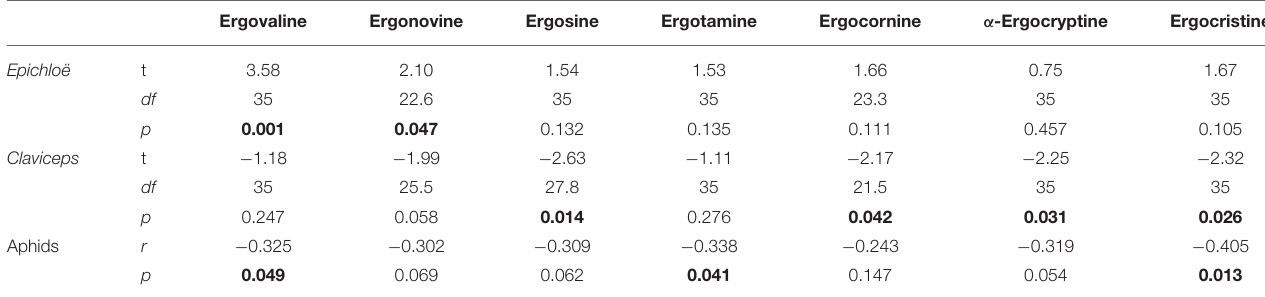
TABLE 2 | Analysis of ergot alkaloids showing which alkaloids were associated with Epichloë symbiosis and visible Claviceps infection and how their concentration correlated with the number of aphids in the same plants. Ergovaline